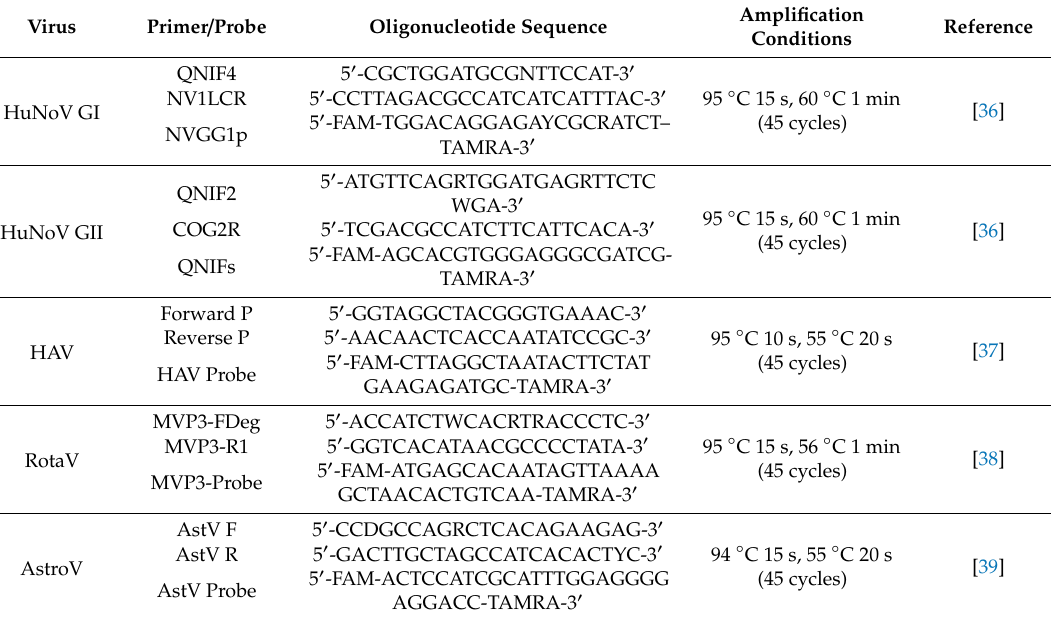
Table 1. Primers and probes utilized for the seven viruses examined in this